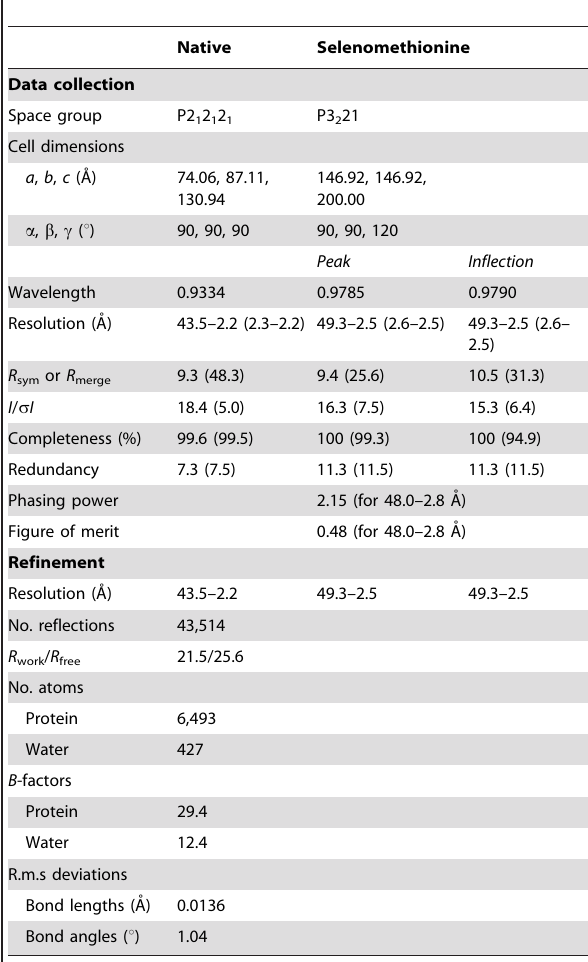
Table 2. Data collection and refinement statistics for Myo5b globular domain (molecular